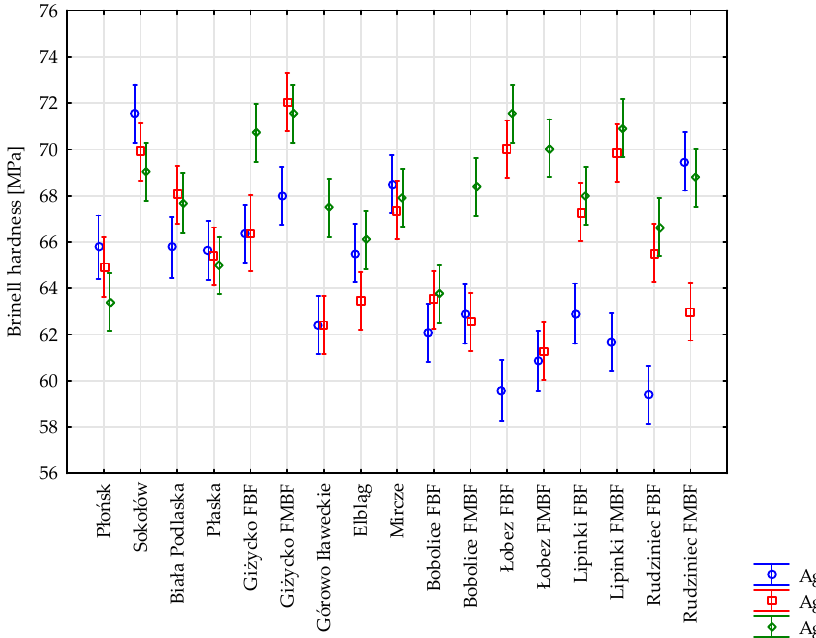
Figure 3. Mean wood hardness values and standard errors, for location and age.